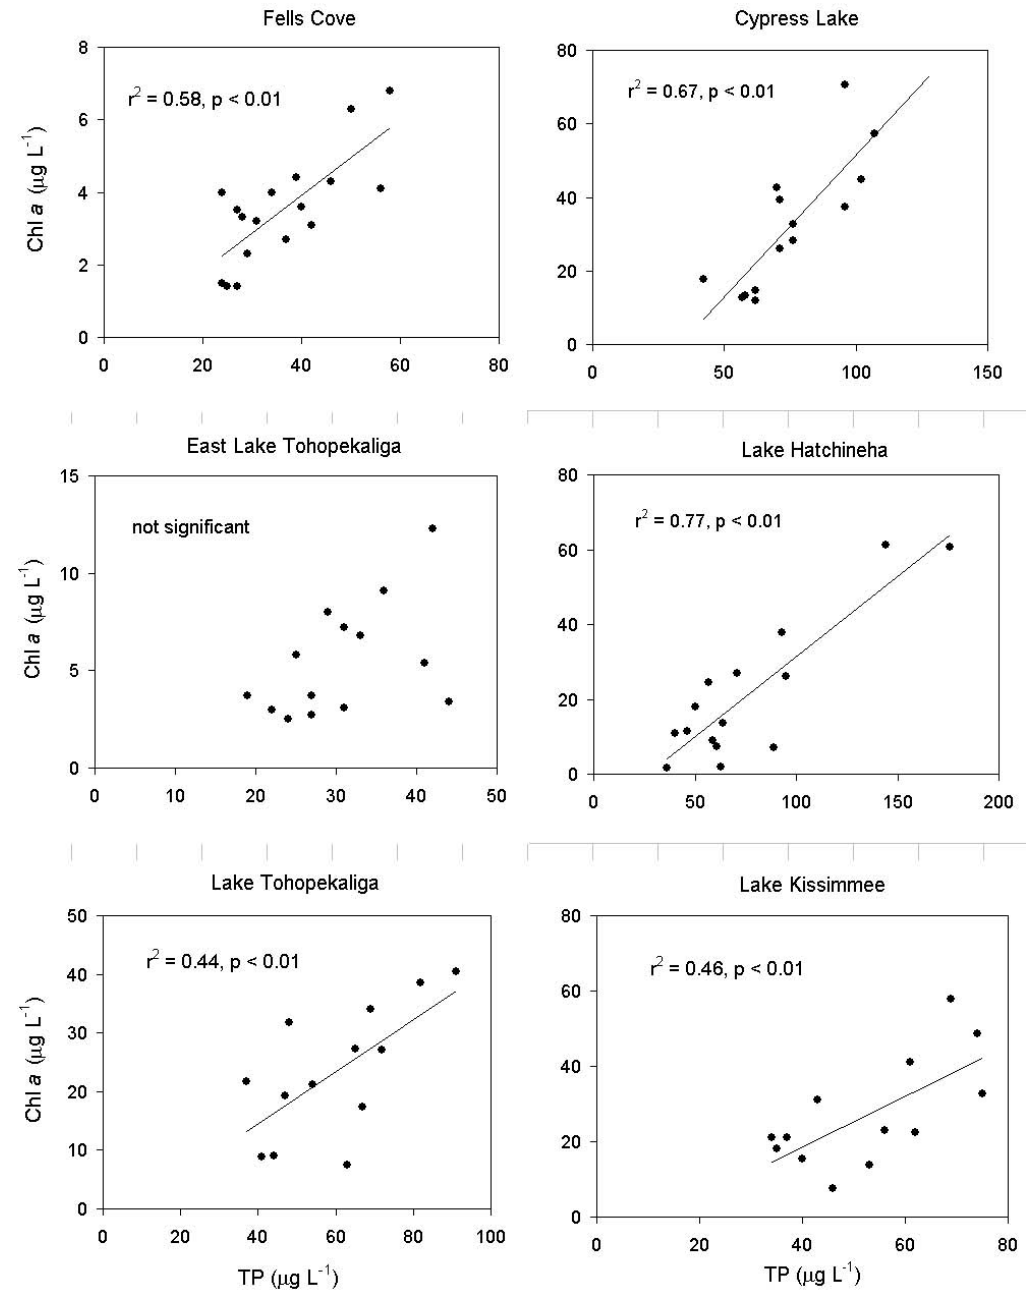
FIGURE 8 . Near-surface concentrations of chlorophyll a (Chl α ), plotted as a function of total phosphorus (TP) on each sampling event, for the six study lakes. Least-squares regression models are included where p values are <0.10. results in zooplankton that largely are dependent on bacteria and protozoa as food resources. The finding that lake-averaged zooplankton biomass in the Kissimmee lakes is strongly related to TP, but not Chl α , supports the notion of resource control of zooplankton by something other than phytoplankton biomass. It is noteworthy that all of the macro-zooplankton taxa encountered in the Kissimmee lakes (with the exception of M. edax ) have been documented to consume